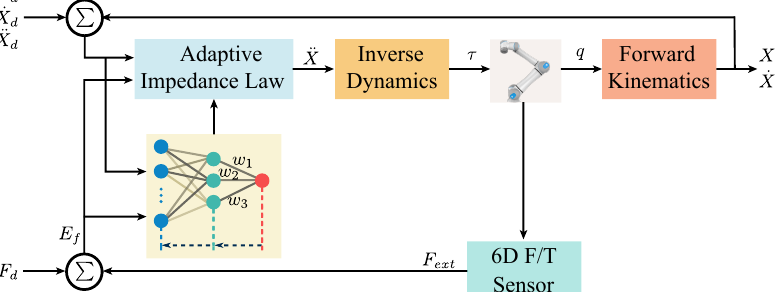
Figure 1. NAIC structure. The neural network consists of three layers: input layer, hidden layer, and output layer. The input contains ¨ e , ˙ e , Φ ( t − λ ) , and e f ( t − λ ) . The output is the force error e f ( t ) . The dark blue dashed line denotes the back propagation. The parameters of the AIC are updated with the neural